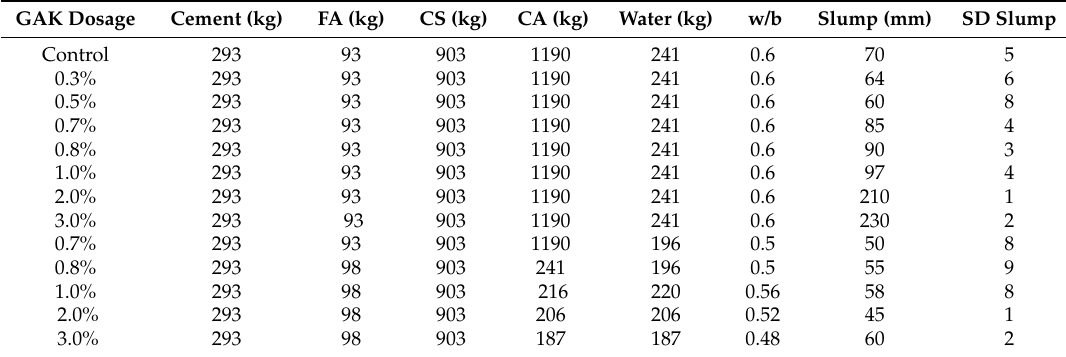
Table 2. Concrete mix proportions and fresh state properties. FA, fly ash; CS, crusher sand; CA, coarse